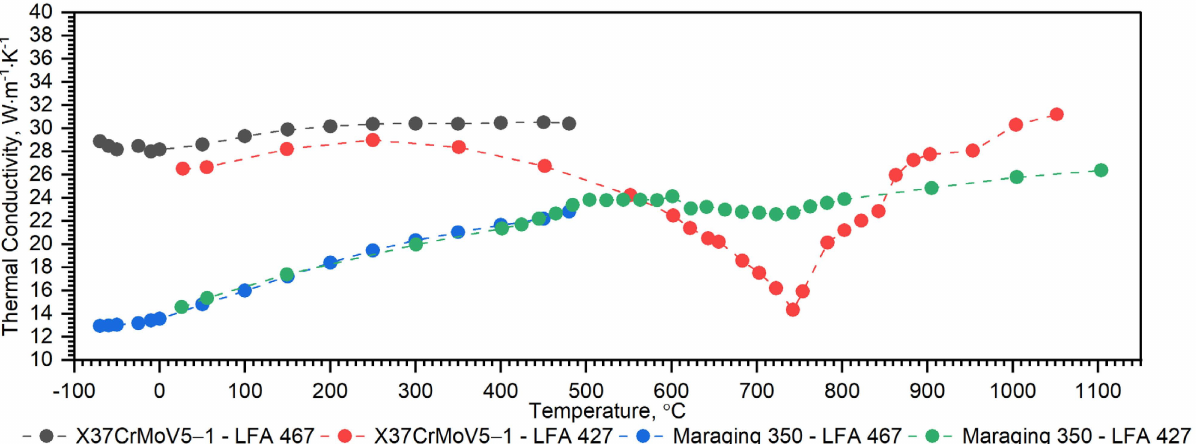
Figure 8. Thermal conductivity as a function of temperature for the X37CrMoV5 − 1 hot-work tool steel and Maraging 350 steel obtained from the first heating runs on LFA 467 and LFA 427.